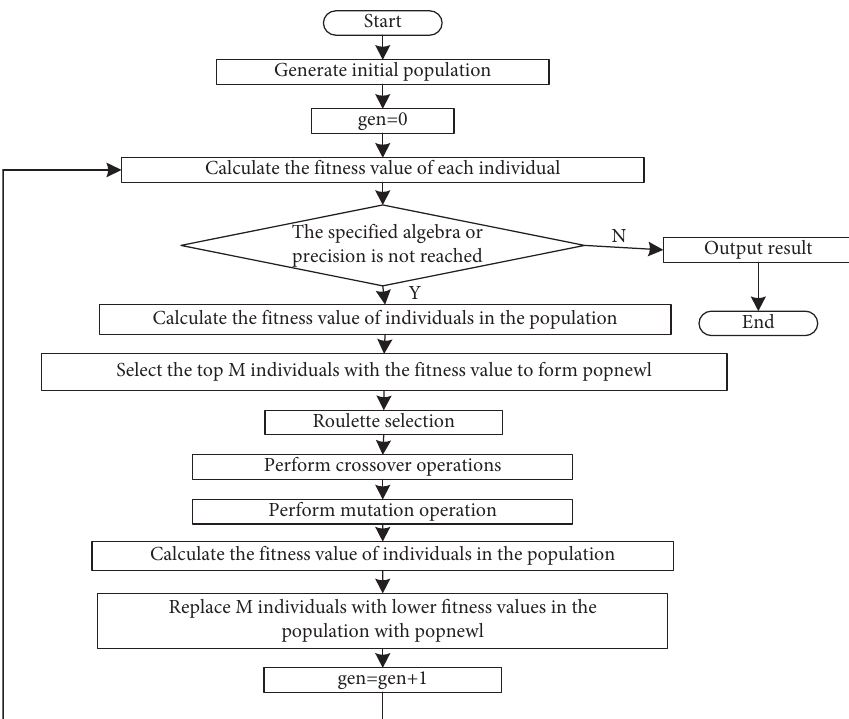
Figure 2: Solution flow using